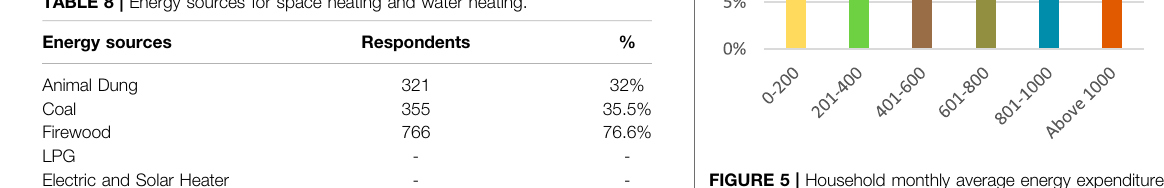
TABLE 8 | Energy sources for space heating and water heating.